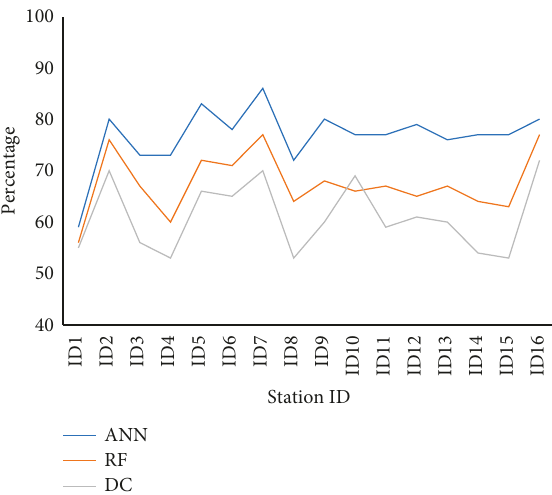
Figure 10: Precision of model for medium passenger in each station.